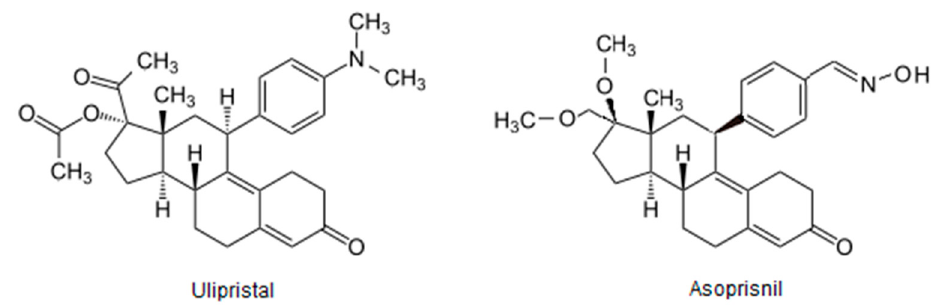
Figure 3. SPRM Figure 3. SPRM structures.